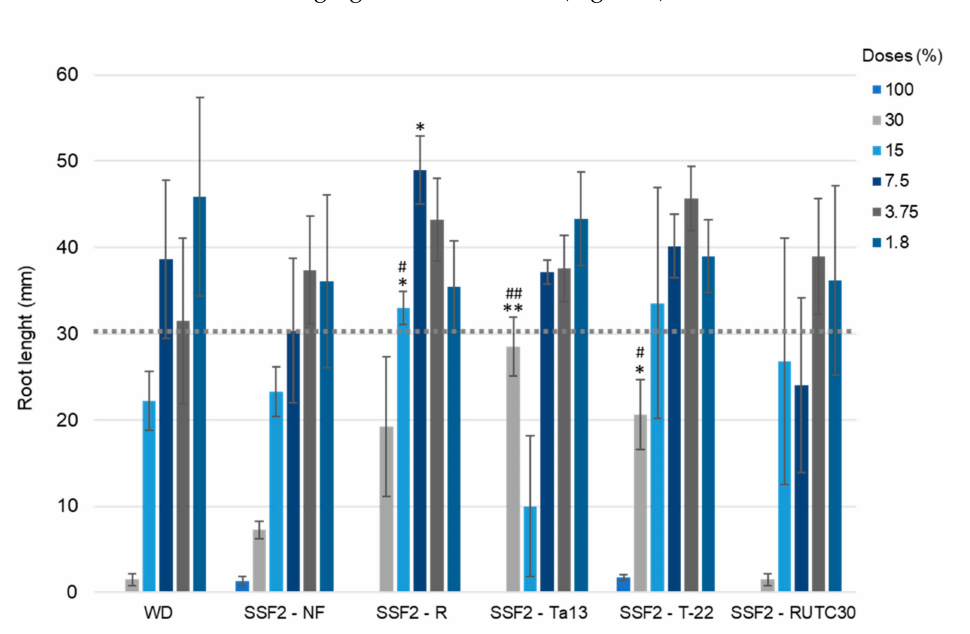
Figure 4. Root elongation of Lepidium sativum seeds treated with different doses of whole digestate (WD), SSF2 not fermented (SSF2-NF) and SSF2 fermented by T. asperellum R (SSF2-R), T. atroviride Ta13 (SSF2-Ta13), T. harzianum T-22 (SSF2-T-22), and T. reesei RUT-C30 (SSF2-RUTC30). Data are